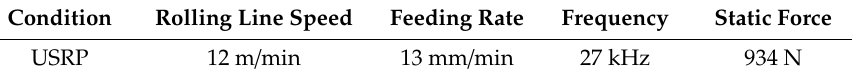
Table 1. Ultrasonic surface rolling process (USRP) processing